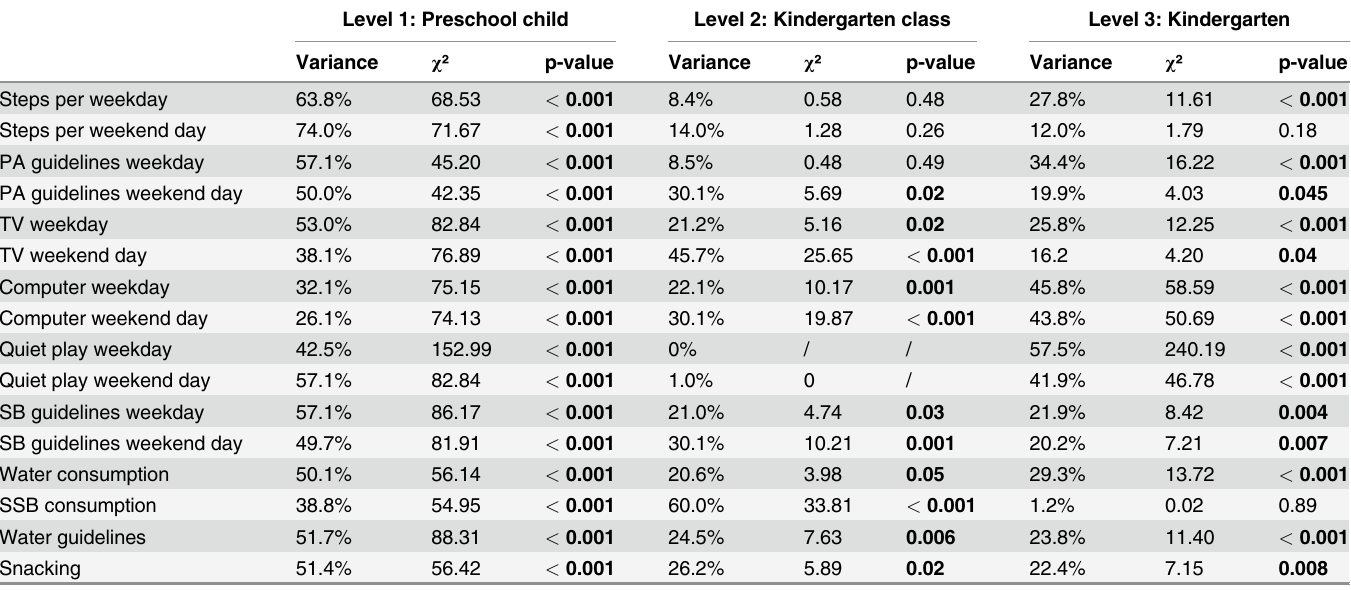
Table 3. Explained variance for each dependent variable at each level of the multilevel